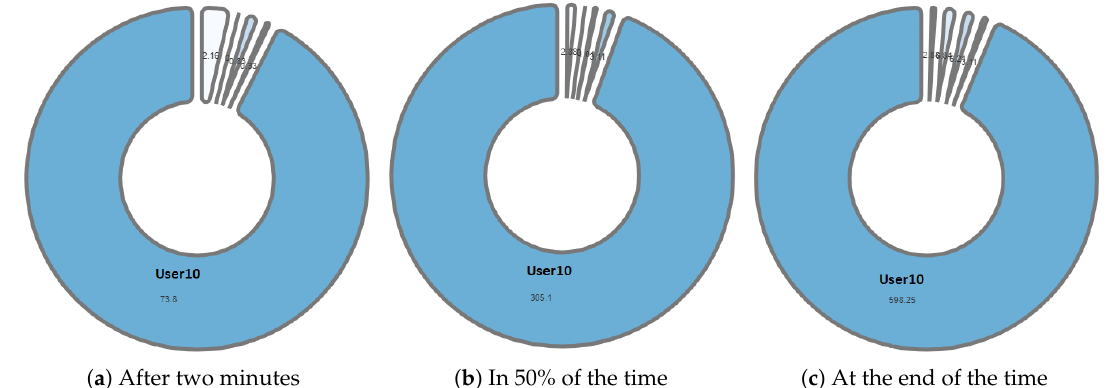
Figure 17. Pie chart with the evolution of G5 speech time distribution.